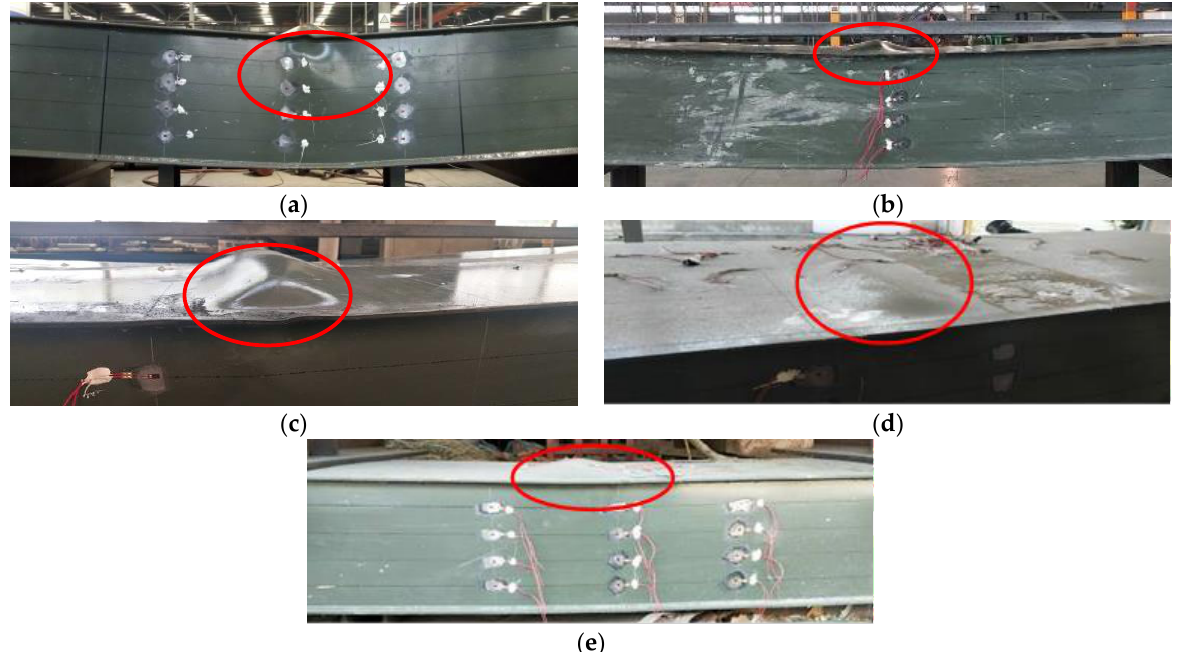
Figure 6. Typical local buckling of specimens: ( a ) Outward local buckling of web; ( b ) Outward local buckling on top steel plate of S-6; ( c ) Outward local buckling on top steel plate of S-7; ( d ) Outward local buckling on top steel plate of S-4; ( e ) Outward local buckling on top steel plate of S-5.